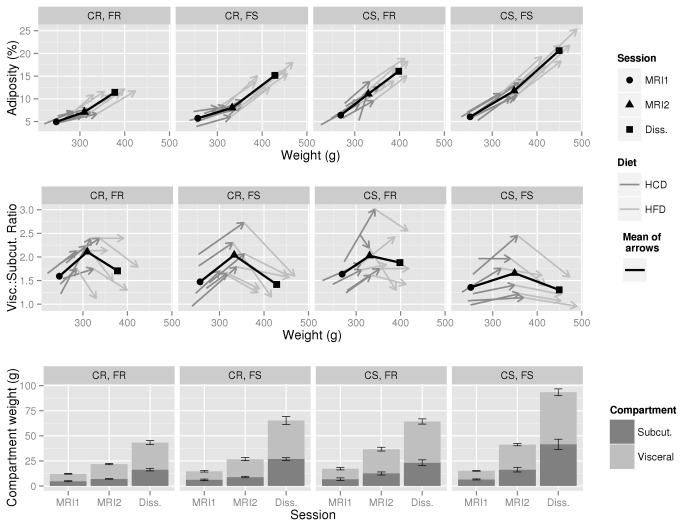
Evolution of body composition during HCD and HFD feeding.The evolution of body adiposity vs. body weight is shown in the top panel, visceral to subcutaneous fat ratio in the middle panel, and subcutaneous and visceral fat pad weights in the lower panel. The 24 rats have been sorted into groups according to whether they were in the upper (sensitive) or lower (resistant) half of rats by adiposity gain under HCD (carbohydrate resistant or sensitive; CR or CS) and/or HFD (fat resistant or sensitive FR or FS). So for example, “CS,FR” means rats that were in the upper half of adiposity gainers while under HCD, and in the lower half under HFD. In the top and middle panels, each arrow path represents a single rat, and the black point-line the mean of the arrows. In the lower panel, error bars are of group SEM. Note that each adiposity group has 6 rats; such a neat sorting was not intentional, but is instead an indication of how loose the link is between adiposity gains under HCD and HFD.